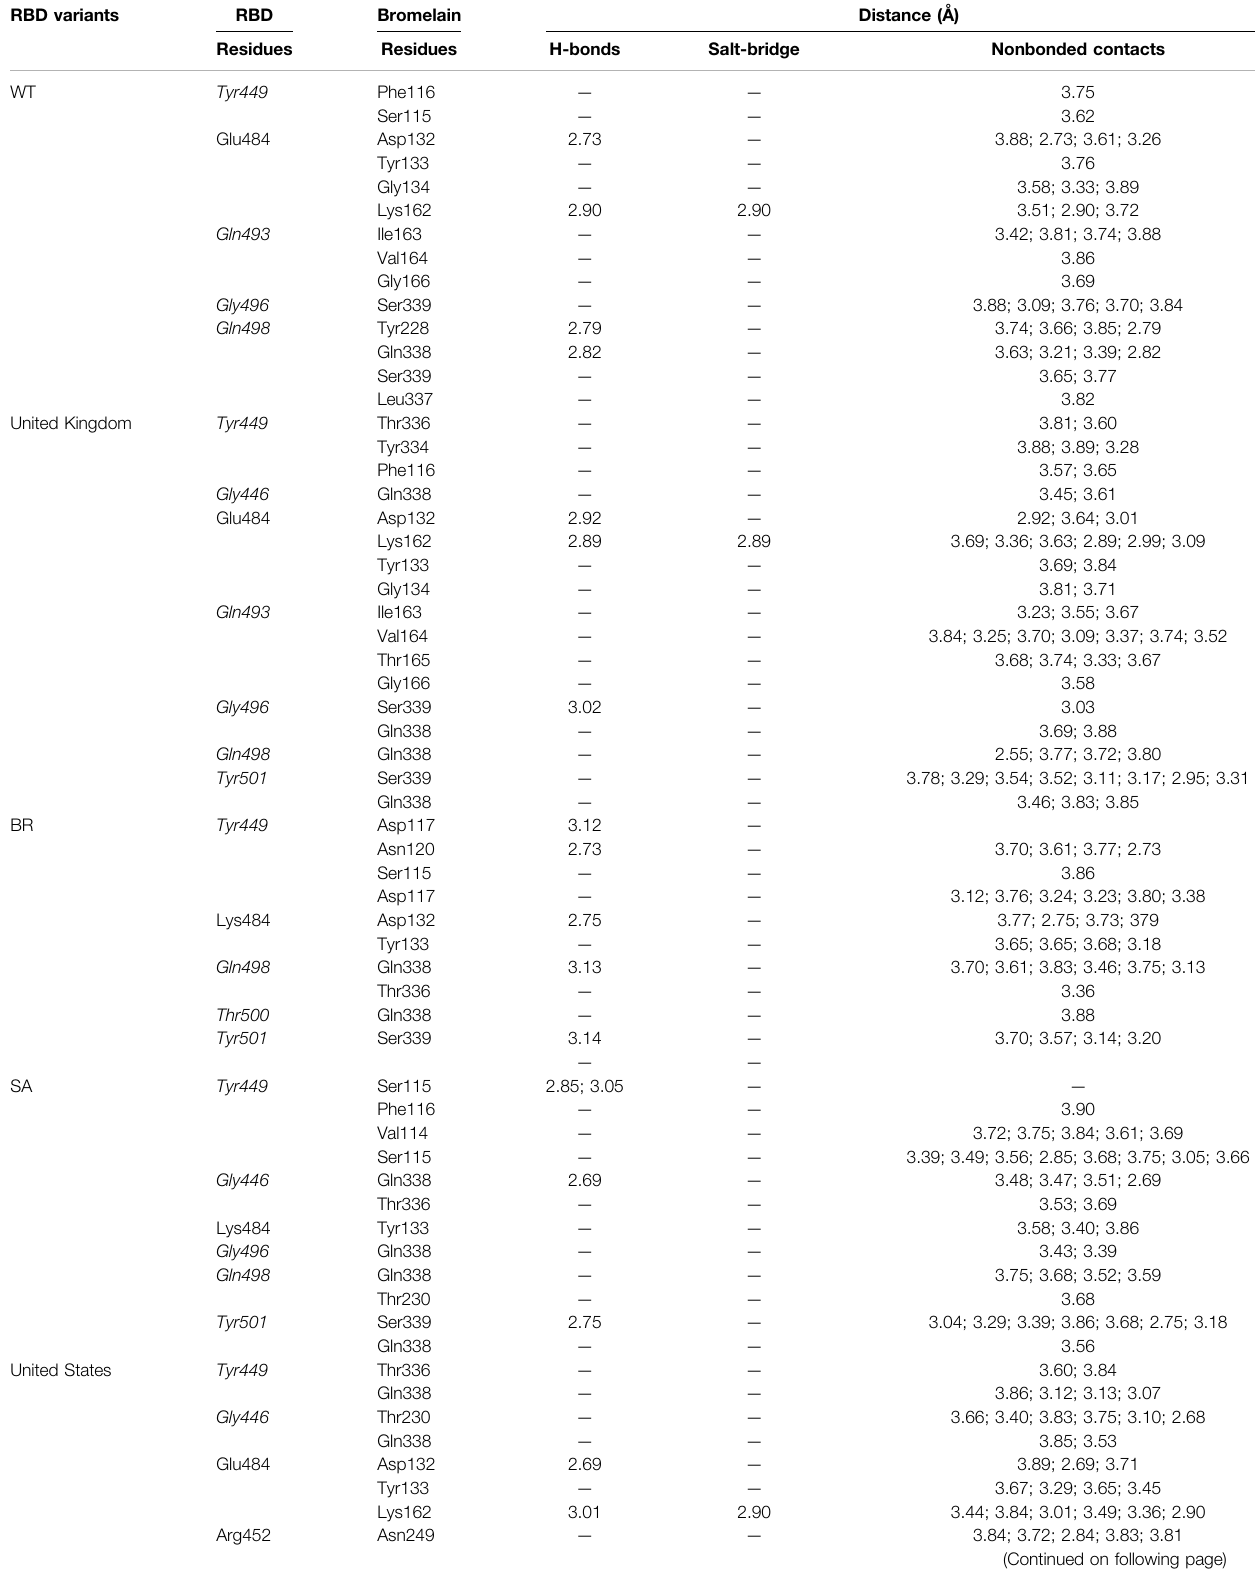
TABLE 5 | Interaction between bromelain and RBDs of the last frame MD simulation on amino acids that are important in the interaction between RBD and hACE2 (marked with italics font). The bold font indicates mutated amino acids. RBD